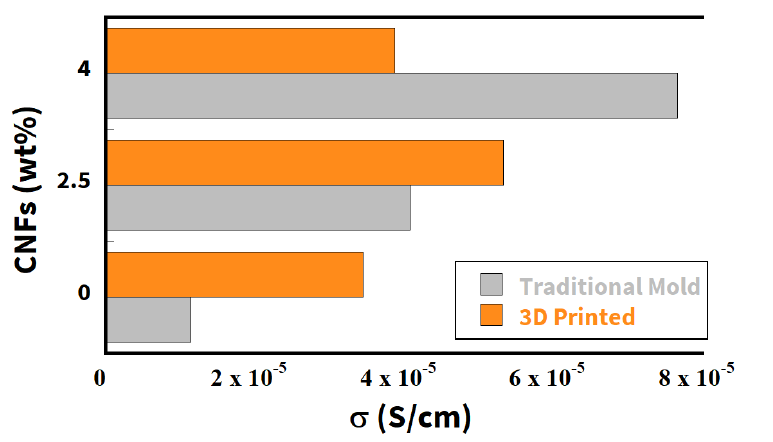
Figure 1. Comparison of electrical conductivity measured by dielectric spectroscopy at RT and at 100 Hz between samples prepared with the traditional casting mold procedure (gray) and 3D printing (orange) as a function of CNF dosage.